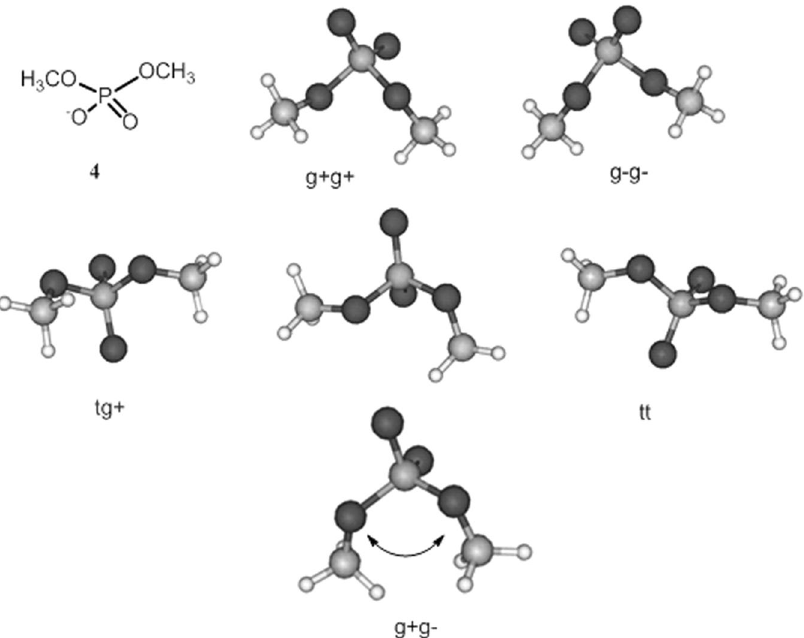
Figure 2. The structure and possible conformations of phosphodiester bridge model 4